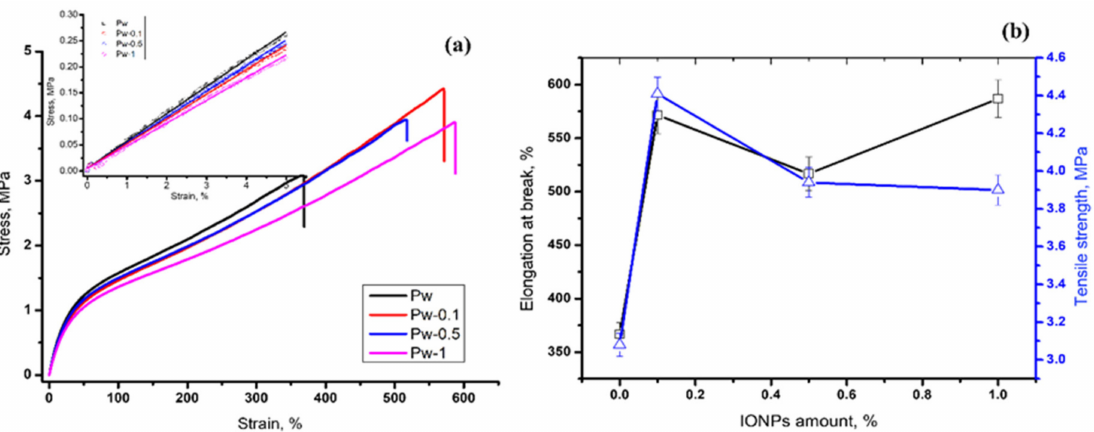
Figure 10. Tensile properties of PU-based composite membranes prepared in wet conditions with different amounts of IONPs: ( a ) stress–strain curves; inset: stress–strain curves in the elastic region; ( b ) variation of elongation at break and tensile strength as a function of the amount of